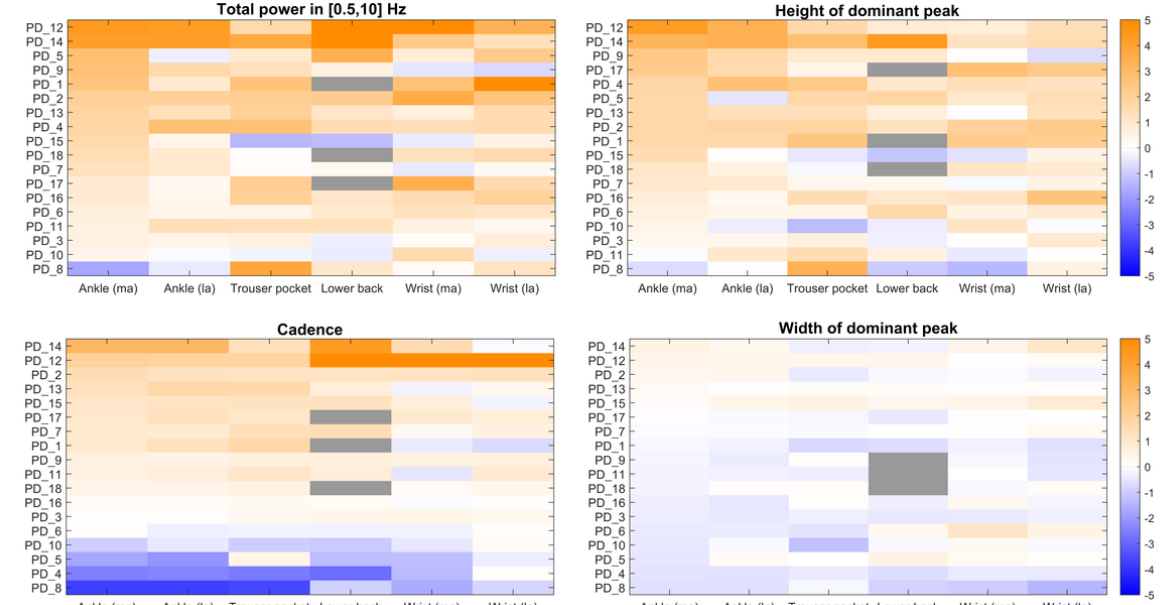
Figure 1. Changes in the 4 signal properties after medication intake, expressed in z scores (color bar). The x-axis displays the various sensor locations; the y-axis shows all individual patients (sorted on the values of the ankle sensor of the most affected side). The figure highlights that the total power and height of the dominant peak increase after medication intake in most patients (with considerable variation between sensor locations), the cadence increases in some but decreases in others (with high agreement between sensor locations), and the width of the dominant peak does not change considerably. Grey areas indicate missing data. la: least affected; ma: most affected; PD: Parkinson